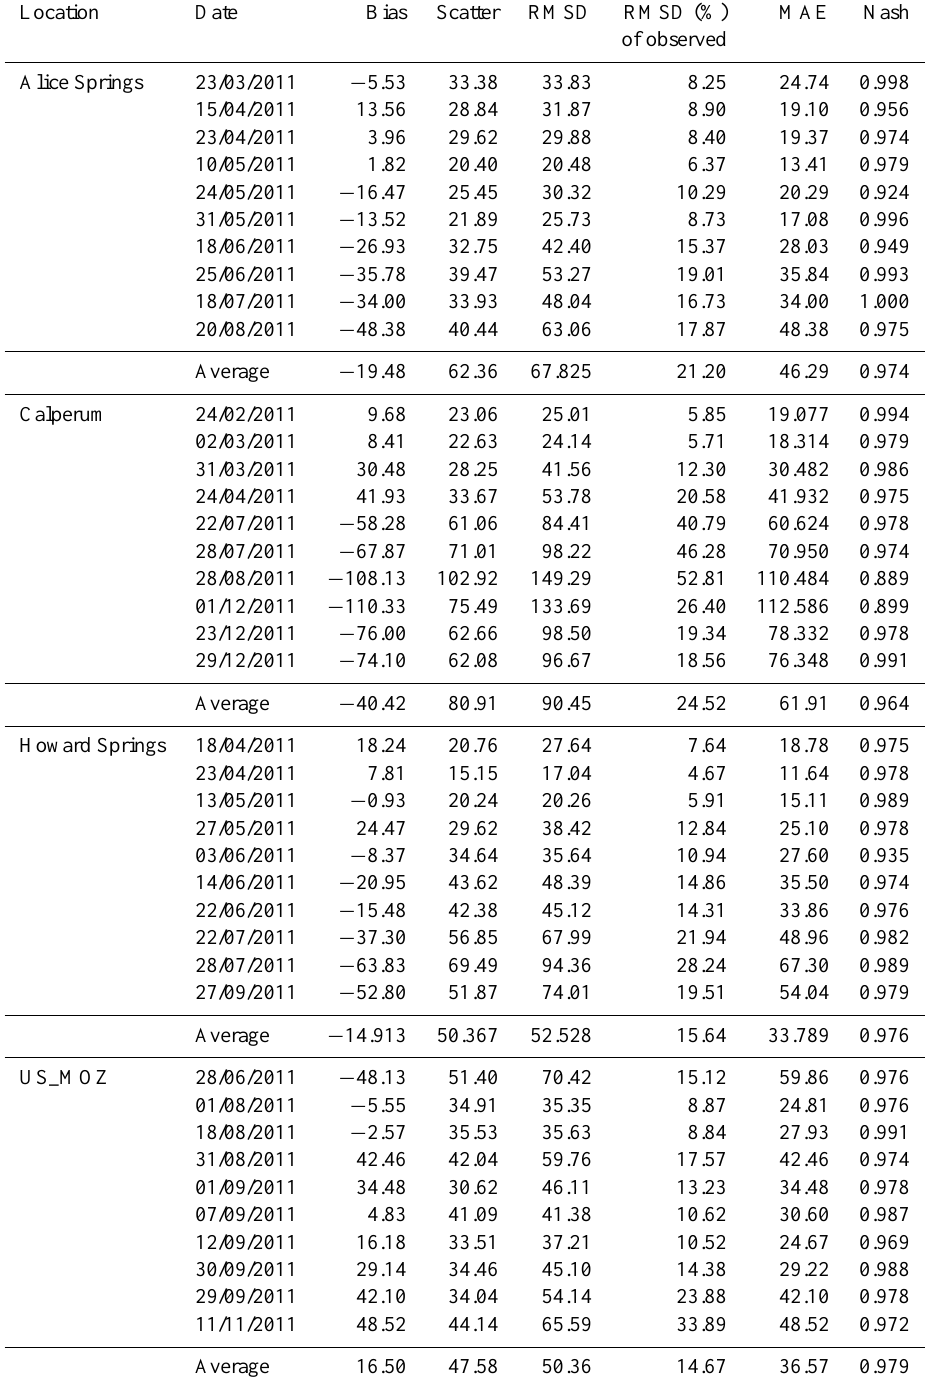
Table 3. Daily simulation accuracy and average site simulation accuracy for R g fluxes. Bias, scatter, RMSD and MAE are expressed in watts per square metre (Wm − 2 ). Nash index is